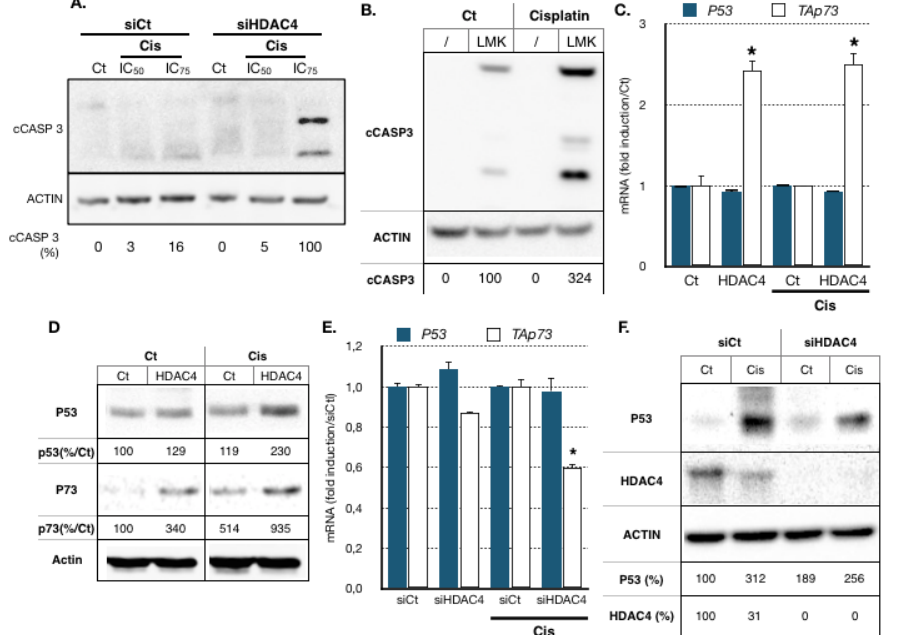
Figure 5. HDAC4 expression correlates with deregulation of cell cycle and proapoptotic pathways regulated by protein of the p53 family. ( A ). Proteins from AGS cells transfected with a siRNA (10 nM) against HDAC4 or luciferase (10 nM, siCtl) for 48 h and treated for 24 h with the indicated concentrations of cisplatin treated or not (Ct) with the indicated concentrations (IC 50 , IC 75 ) of cisplatin were separated on an SDS PAGE gel. A Western blot experiment was performed using an antibody against cleaved caspase 3 (cCASP3), and actin was using as loading control. Percentage of cleaved Caspase 3 is indicated relative to siHDAC4 / Cis(IC 75 ) and corrected with actin level. ( B ). Proteins from AGS cells treated with cisplatin (IC 50 ) and LMK235 (IC 25 ) for 24 h were separated on an SDS PAGE gel. A Western blot experiment was performed using an antibody against cleaved caspase 3, and actin was using as loading control. ( C,D ). AGS cells were transfected with a plasmid encoding for HDAC4 (1 µ g) or an empty vector (pcDNA3, Ct) for 24 h and then treated for 12 h with cisplatin. Expression of p53 and TAp73 was assayed by RT-qPCR ( A ) and Western blot ( B ). *, p < 0.001 ( n = 3), compared with the control as calculated by one-way ANOVA followed by a Tukey post-test. Percentage of protein is indicated relative to the condition Ct / Ct and corrected with actin level. ( E,F ). AGS cells were transfected with a siRNA (10 nM) against HDAC4 or luciferase (10 nM, siCt) for 48 h and treated with cisplatin for 12 h. Expression of p53 and TAp73 was assayed by RT-qPCR (E). Protein level for p53 and HDAC4 were assayed by Western blot ( F ). *, p < 0.001 ( n = 3), compared with the si control as calculated by one-way ANOVA followed by a Tukey post-test. Percentage of protein is indicated relative to the condition siCt / Ct and corrected with actin